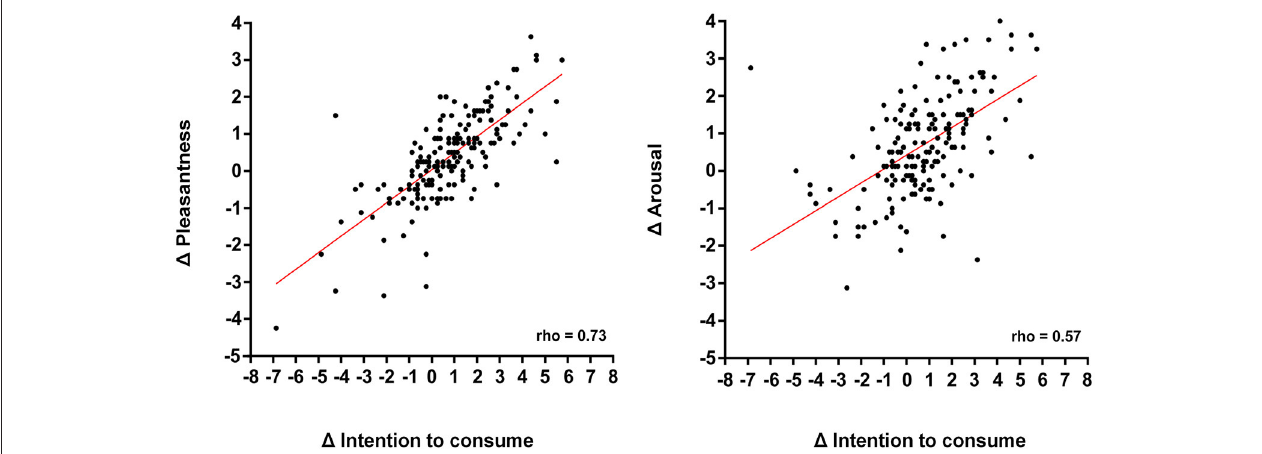
FIGURE 4 | Correlations between the emotional reactivity index obtained from pleasantness (left panel) and arousal (right panel) ratings and the index obtained from the “intention to consume” ratings. The index was calculated by subtracting the mean ratings assigned for the UMPF from the mean ratings assigned for the UPF (delta = UPF minus UMPF). UMPF, unprocessed/minimally processed foods; UPF, ultra-processed